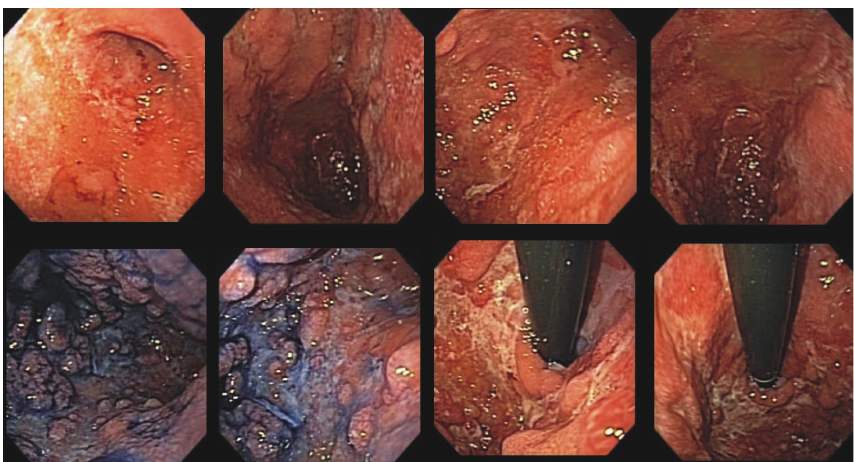
Figure 1: Gastric endoscopic aspects before treatment.